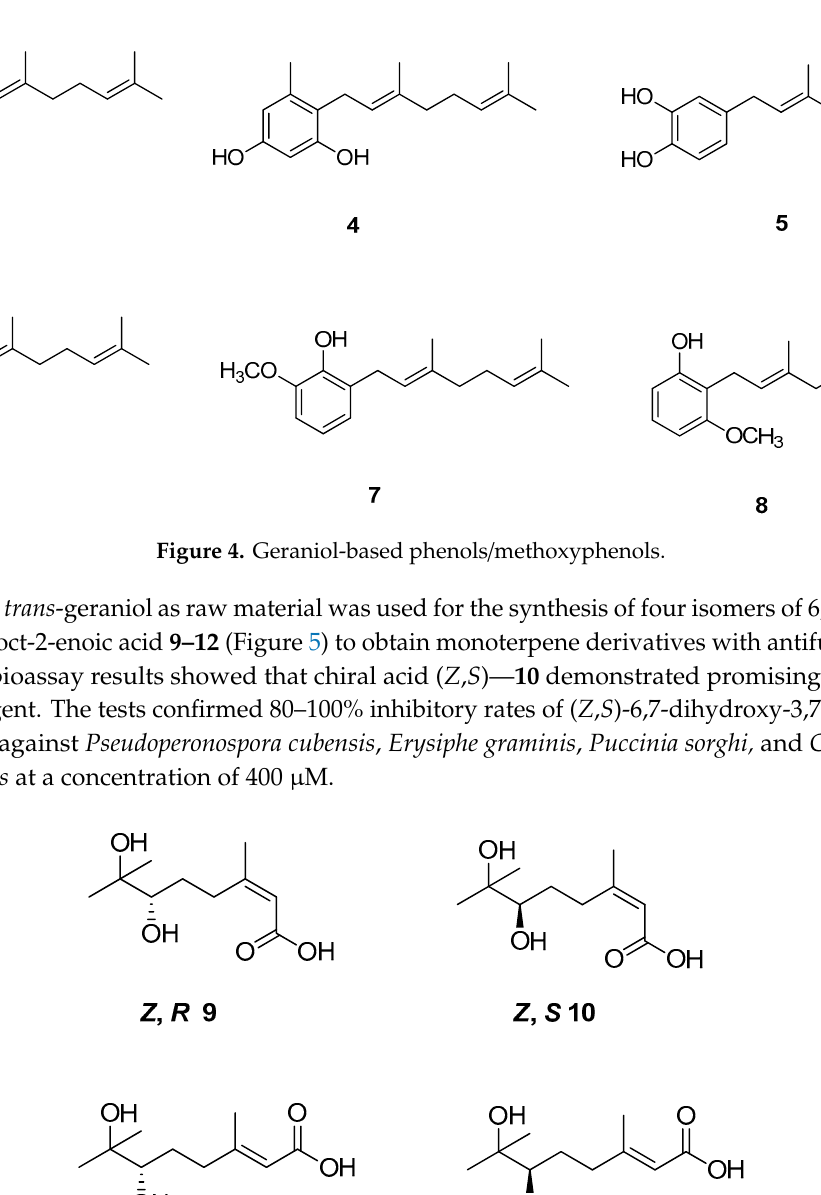
Figure 5. The isomers of 6,7-dihydroxy-3,7-dimethyloct-2-enoic acid derivatives of geraniol.